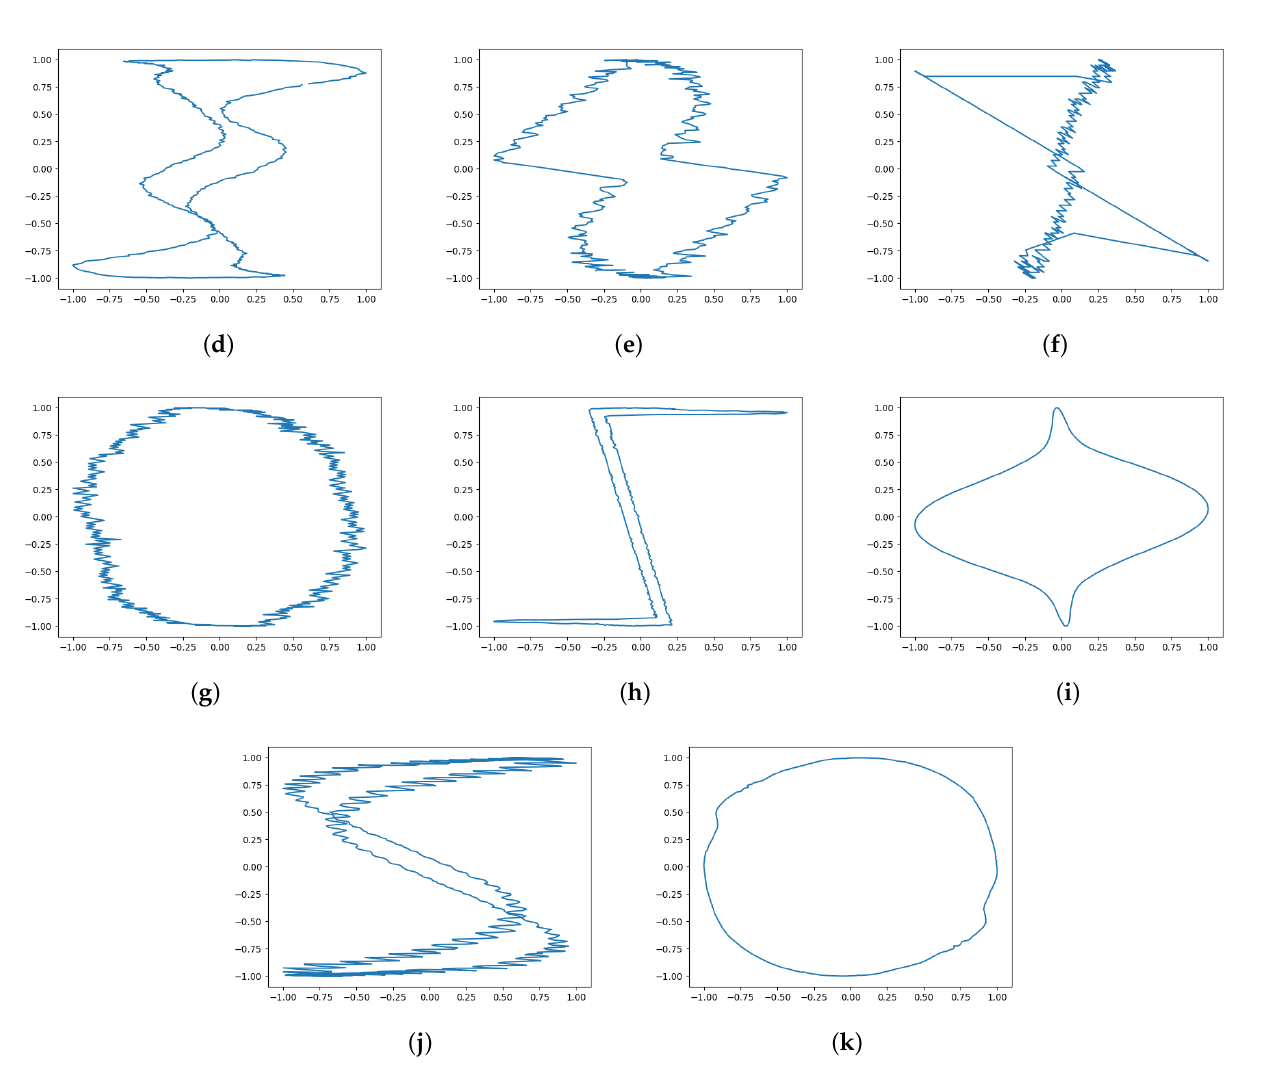
Figure 4. The generated original images of ( a ) air conditioner, ( b ) compact fluorescent lamp, ( c ) fan, ( d ) fridge, ( e ) hairdryer, ( f ) heater, ( g ) incandescent light bulb, ( h ) laptop, ( i ) microwave, ( j ) vacuum, and ( k ) washing machine for PLAID dataset.